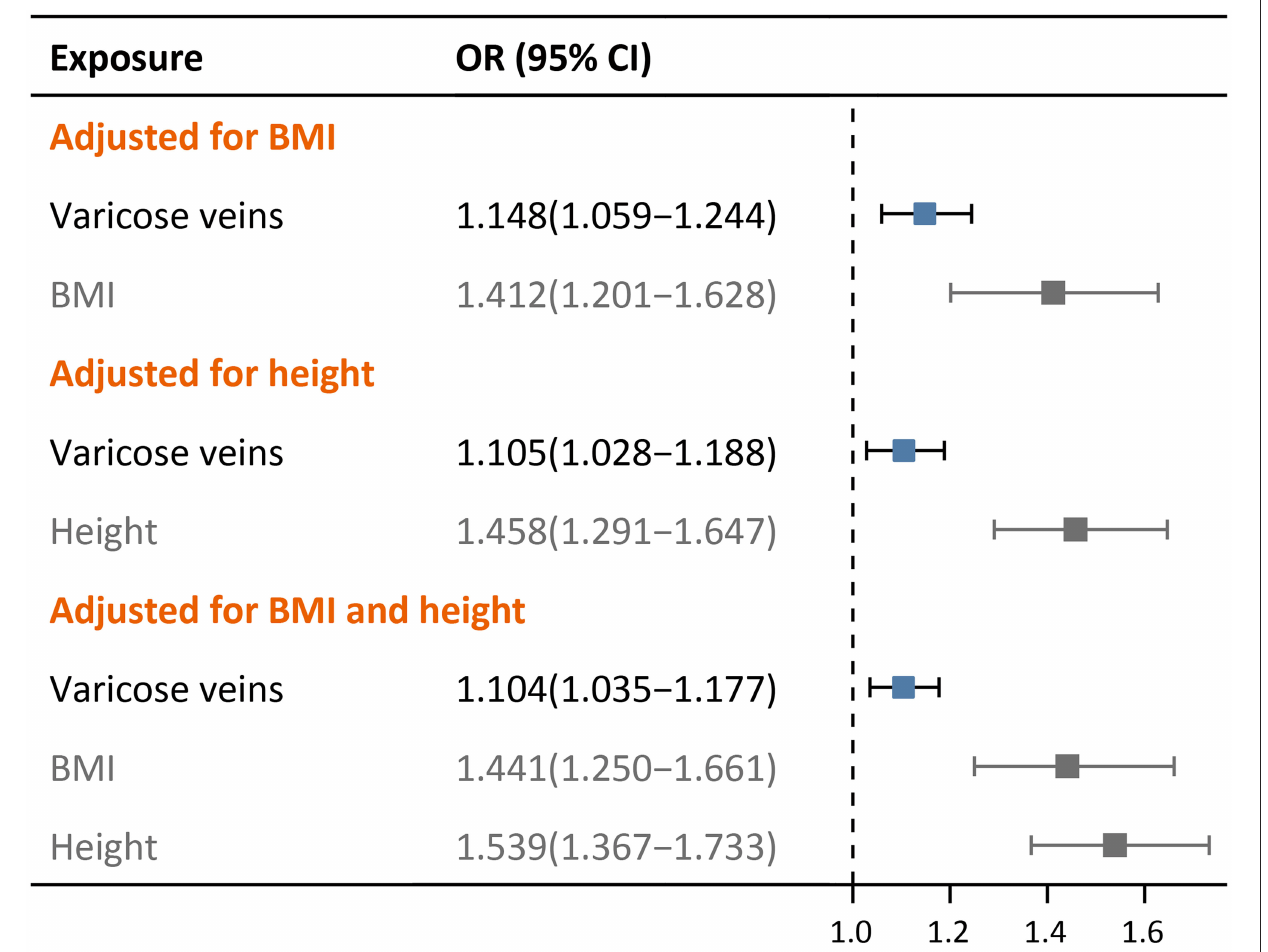
FIGURE 4 | Forest plots of multivariable MR adjusted for BMI and/or